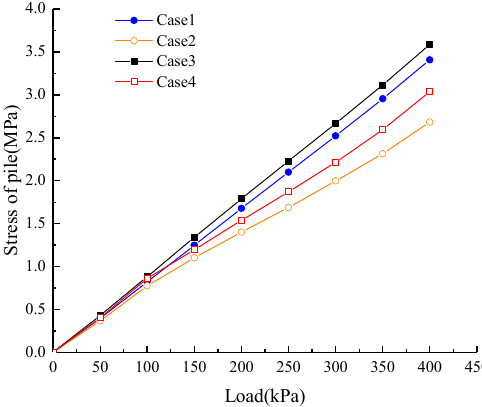
Figure 17. Load–stress curve of pile.